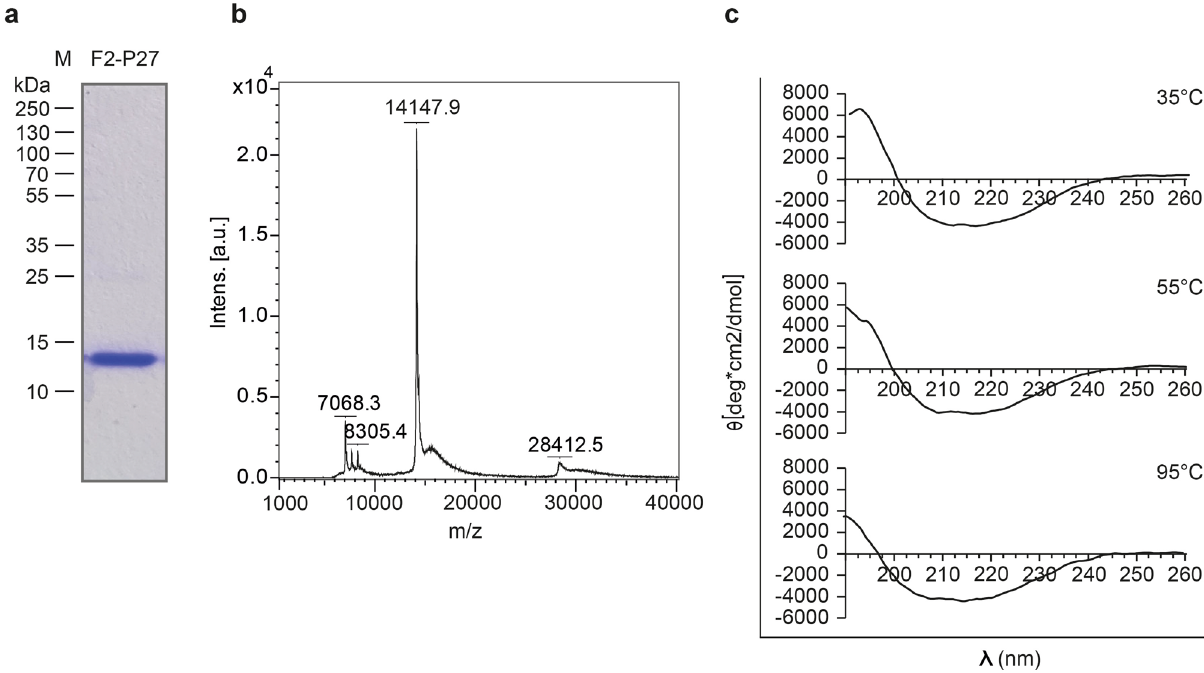
Figure 2. Characterization of recombinant F2-P27 protein. ( a ) Coomassie brilliant blue-stained SDS- PAGE showing purified F2-P27 subunit. Molecular weights (kDa) are indicated on the left margin. ( b ) Mass spectrometry of recombinant F2-P27 subunit. The mass/charge (m/z) ratios are shown on the x-axes, and the intensities are displayed on the y-axes in arbitrary units (a.u.). ( c ) Far-UV CD spectra of F2-P27 subunit at different temperatures (35°C, 55°C and 95°C). Mean residue ellipticities (θ) (y-axes) at given wavelengths (x-axes).